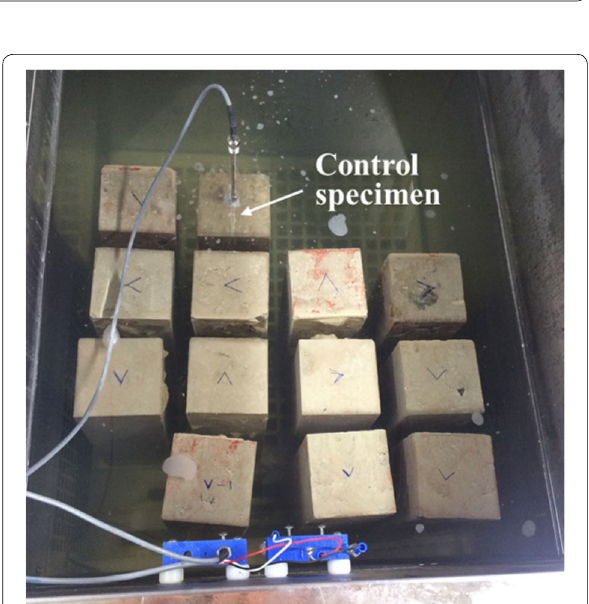
Fig. 12 Test setup: freezing–thawing resistance